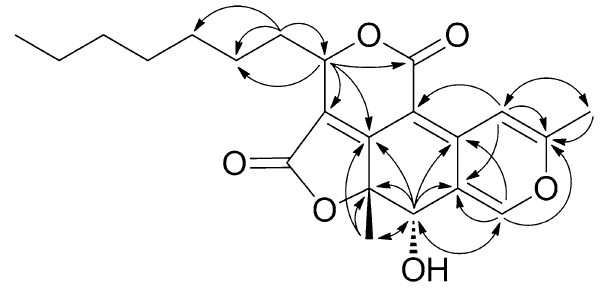
Fig. 2 Key HMBC correlations for compound